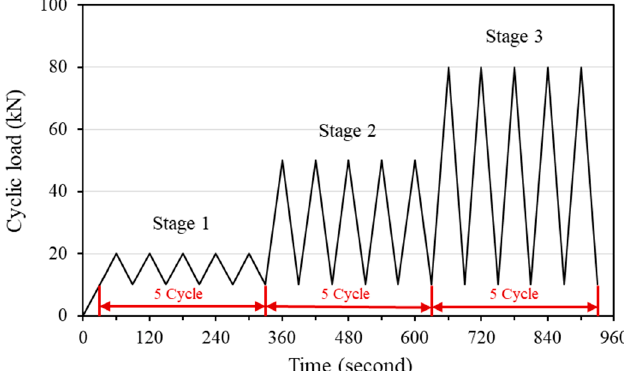
Figure 3. Cyclic loading protocol for the self ‐ sensing test.